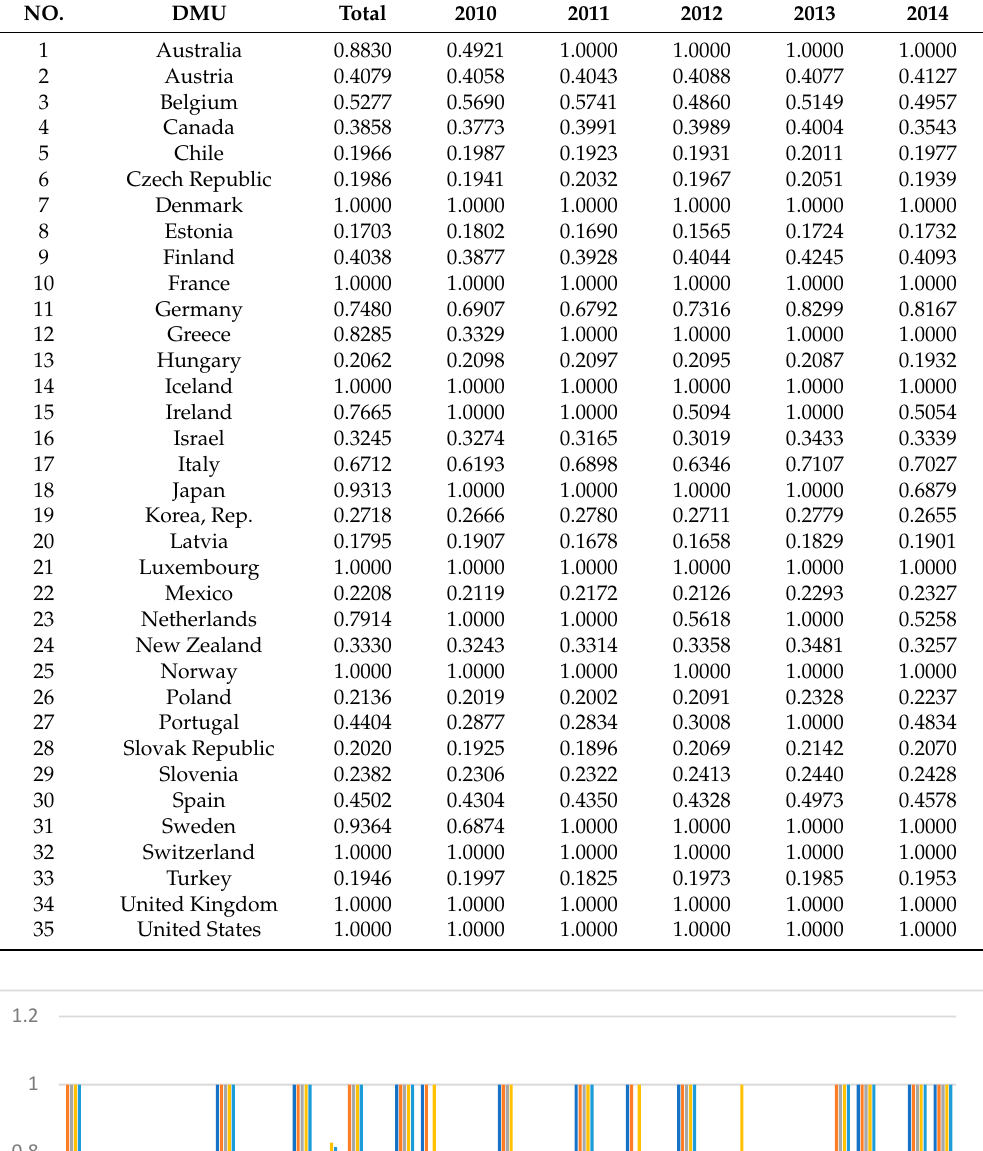
Table 2. Overall and annual efficiencies by country.